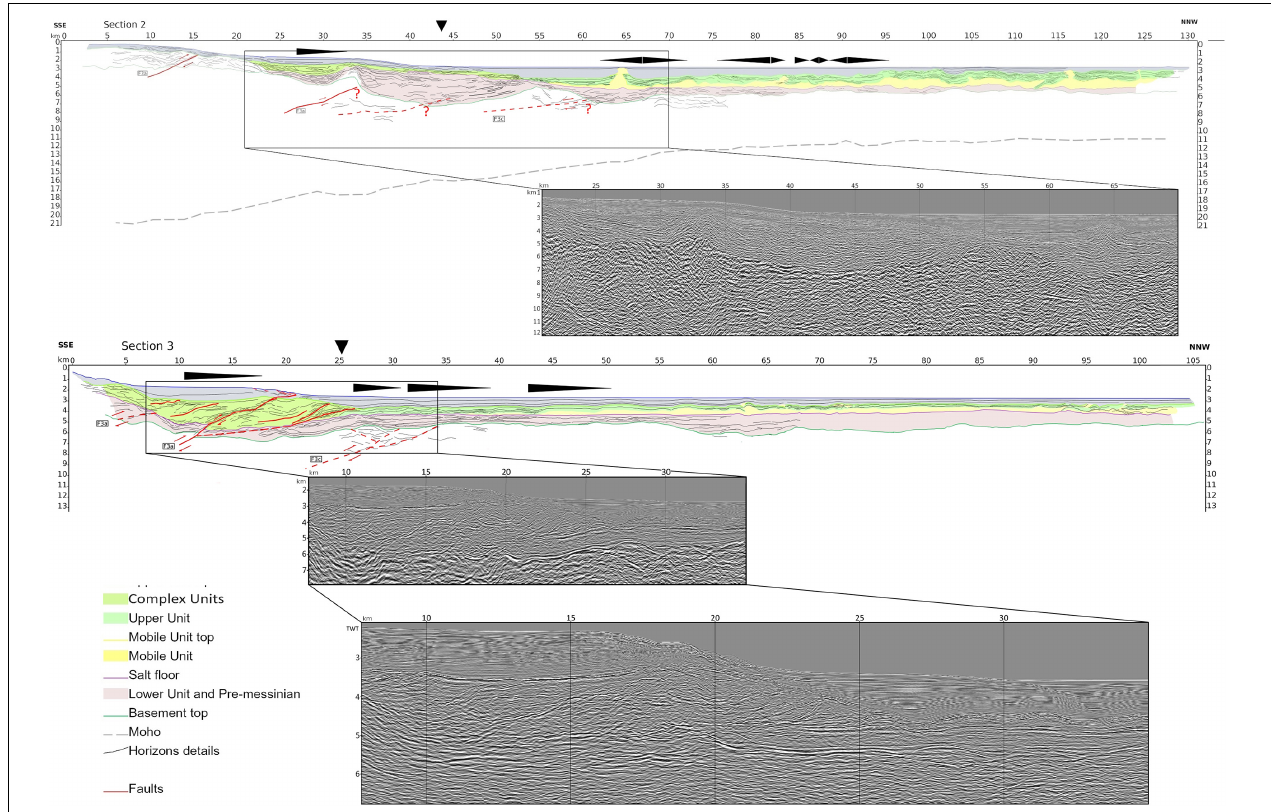
FIGURE 6 | (Right) Seismic Section 2 (Tipaza) as a depth-converted line drawing. No vertical exaggeration is present and faults are identified, as well as major asymmetric basins. The inset displays a raw depth-converted extraction of the seismic line. (Left) Seismic Section 3 (Greater Kabylia) as a line drawing. No vertical exaggeration. Major horizons and faults are identified, as well as major asymmetric basins. Inset displays a raw depth-converted extraction of the seismic line. The inset on the second line is an extraction of the two-way-time section provided to better evidence faults-related shifts and the deformation of the sediments. Light green unit in the margin corresponds to the Messinian Complex unit (CU) coeval to UU and deposited in response to the major sea level drop of the Messinian Salinity Crisis. Stretched black triangles underline post-Messinian depocenters of sub-basins and their potential asymmetry (wedge-shaped sedimentary units or growth strata) which is assumed to evidence a tectonic control by underlying blind flat-ramp thrusts. Downward pointing arrows locate the ocean-continent